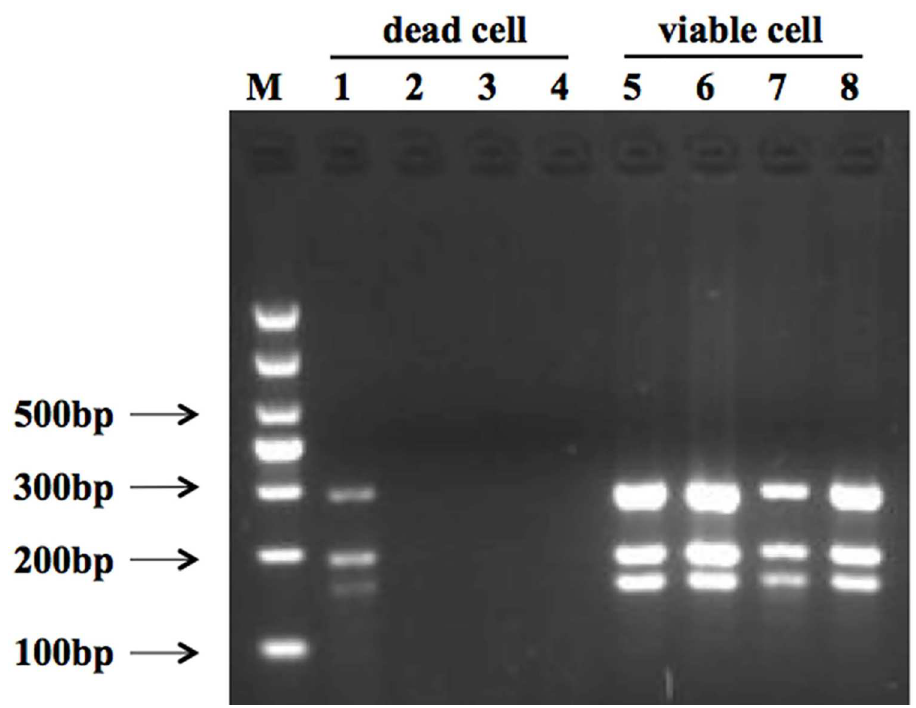
Fig 5. Result of multiplex PCR detection for dead and viable pathogens via PMA treatment. Lane M shows the 1000 bp DNA marker. Lanes 1–4 show genomicDNA extracted from dead L . monocytogenes , E . coli O157:H7, and S . aureus followingPMA treatment (5 μ g/ml, 10 μ g/ml, 20 μ g/ml, and 40 μ g/ml, respectively). Lanes 5–8 show genomicDNA extracted from viable L . monocytogenes , E . coli O157:H7, and